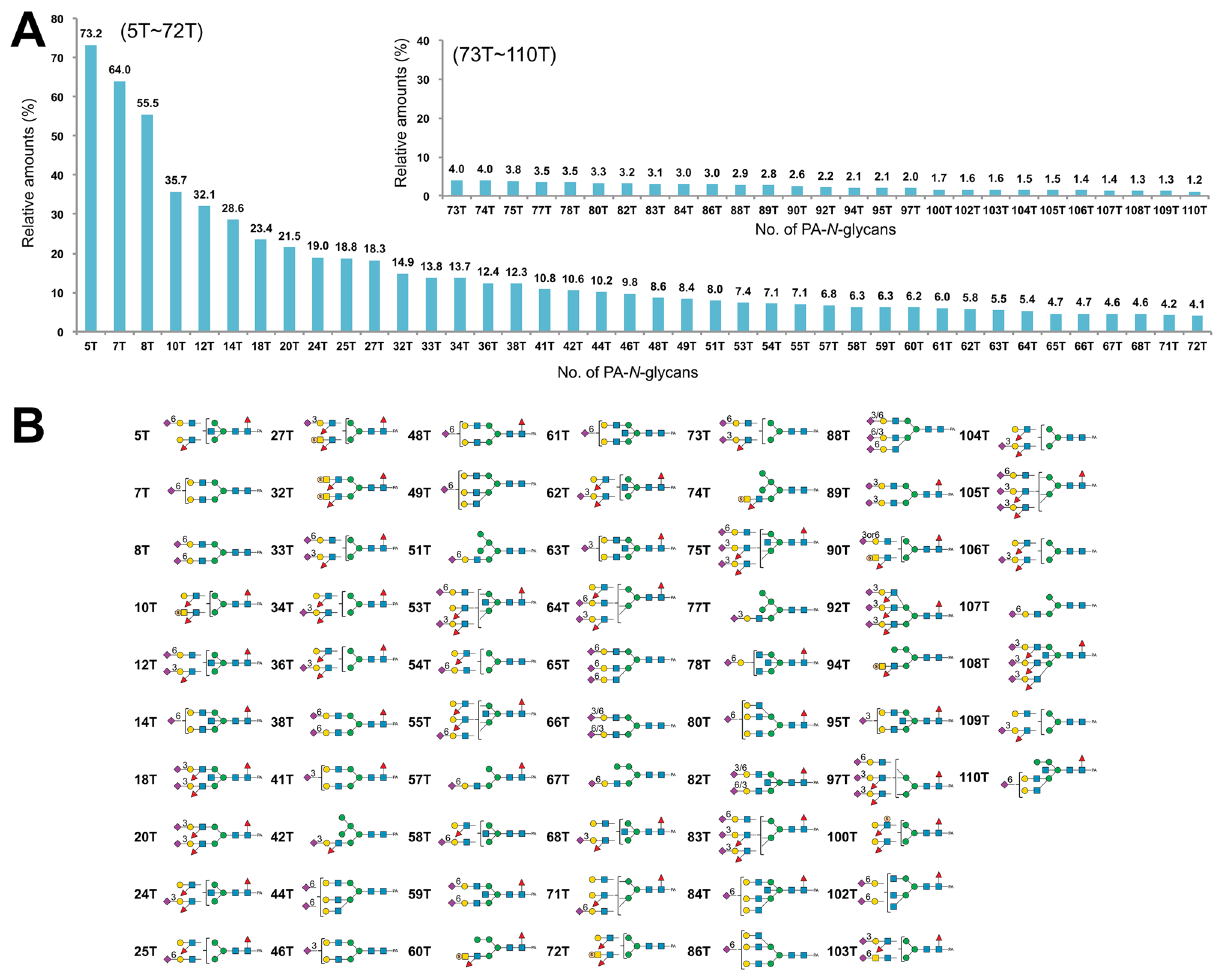
Figure 7. Structures and relative amounts of sialylated and/or sulfated PA- N -glycans from chicken trachea and lung. ( A , C ) Relative amounts of sialylated and/or sulfated PA- N -glycans of trachea ( A ) and lung ( C ). The upper values on each bar of the graph indicate the % of each glycan relative to the most abundant glycan (Man 9 GlcNAc 2 -PA (pk.1-9-1, 1T) in Supplementary Table S1A and S3 for chicken trachea, Gal descending order of relative amount in each tissue (1T–111T and 1L–187L in Table S3). ( B , D ) Structures of the numbered PA- N -glycans in A (trachea) and C (lung), respectively. Sia-linkages (α2,3, α2,6) that were identified unambiguously are indicated by a number between the Sia and Gal/GalNAc